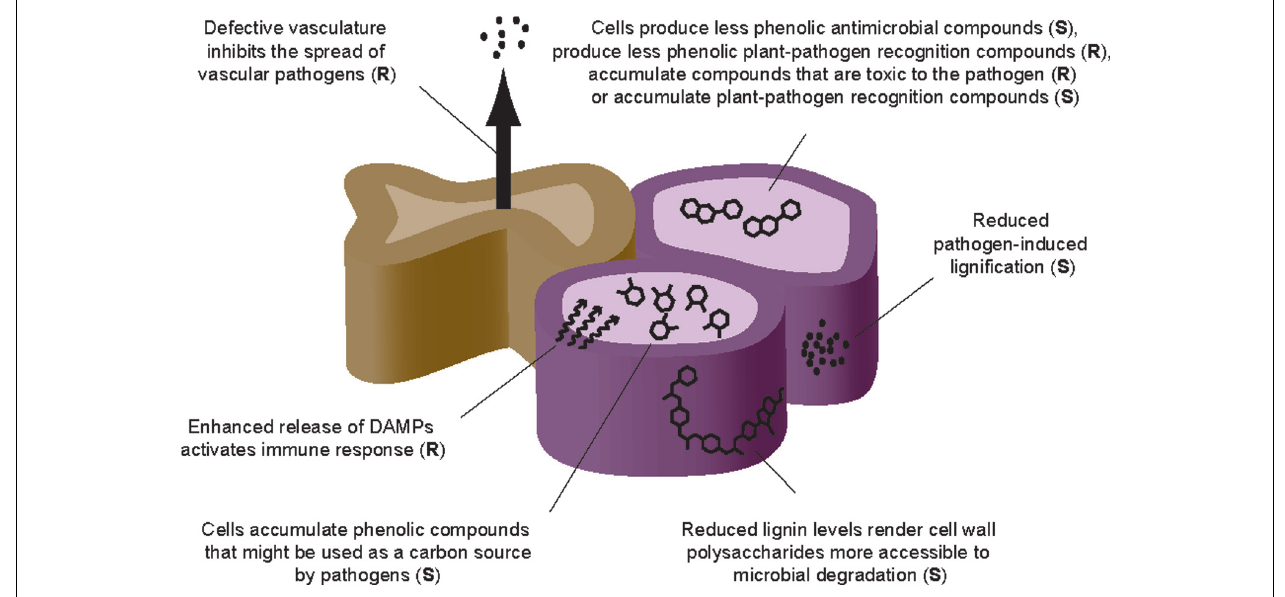
FIGURE 2 | Model illustrating lignin and secondary cell wall modifications resulting in enhanced resistance (R) or enhanced susceptibility (S) to pathogens.